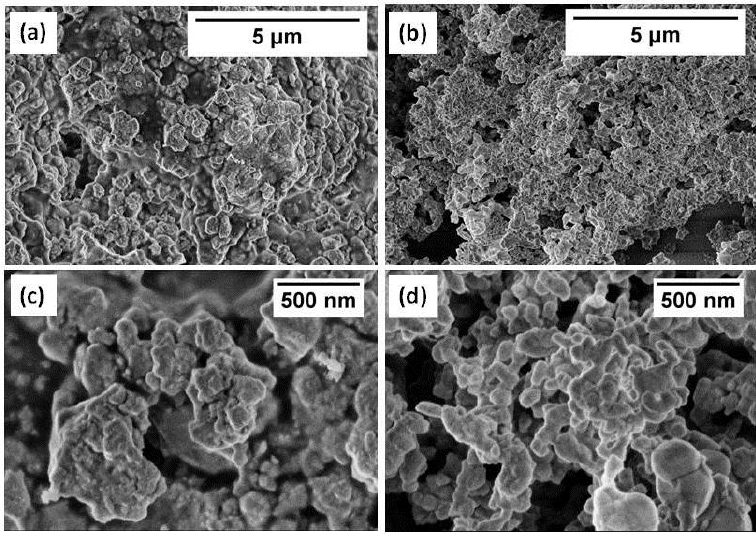
Figure 5. SEM micrographs of ( a ) commercial STFO60 (10 kX); ( b ) Sono-STFO40 (10 kX); ( c ) commercial STFO60 (50 kX); ( d ) Sono-STFO40 (50 kX).